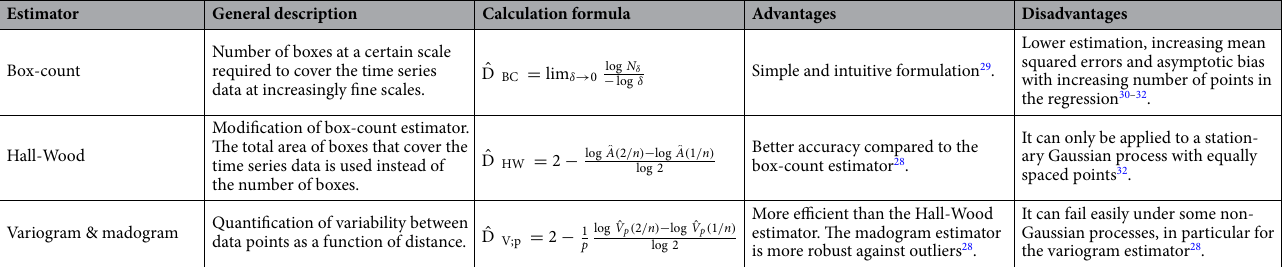
Table 1. Characteristics of fractal dimension estimators. N = number of boxes; δ = boxwidth; area of of boxes; n = number of observations;